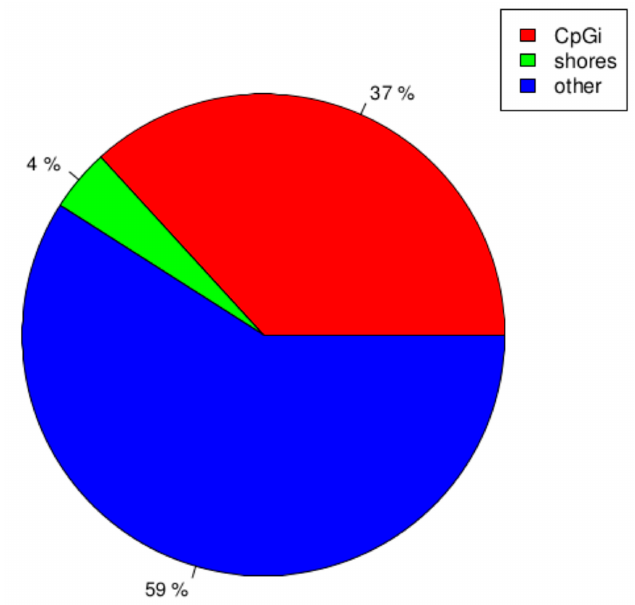
Figure 3. Location of differentially methylated